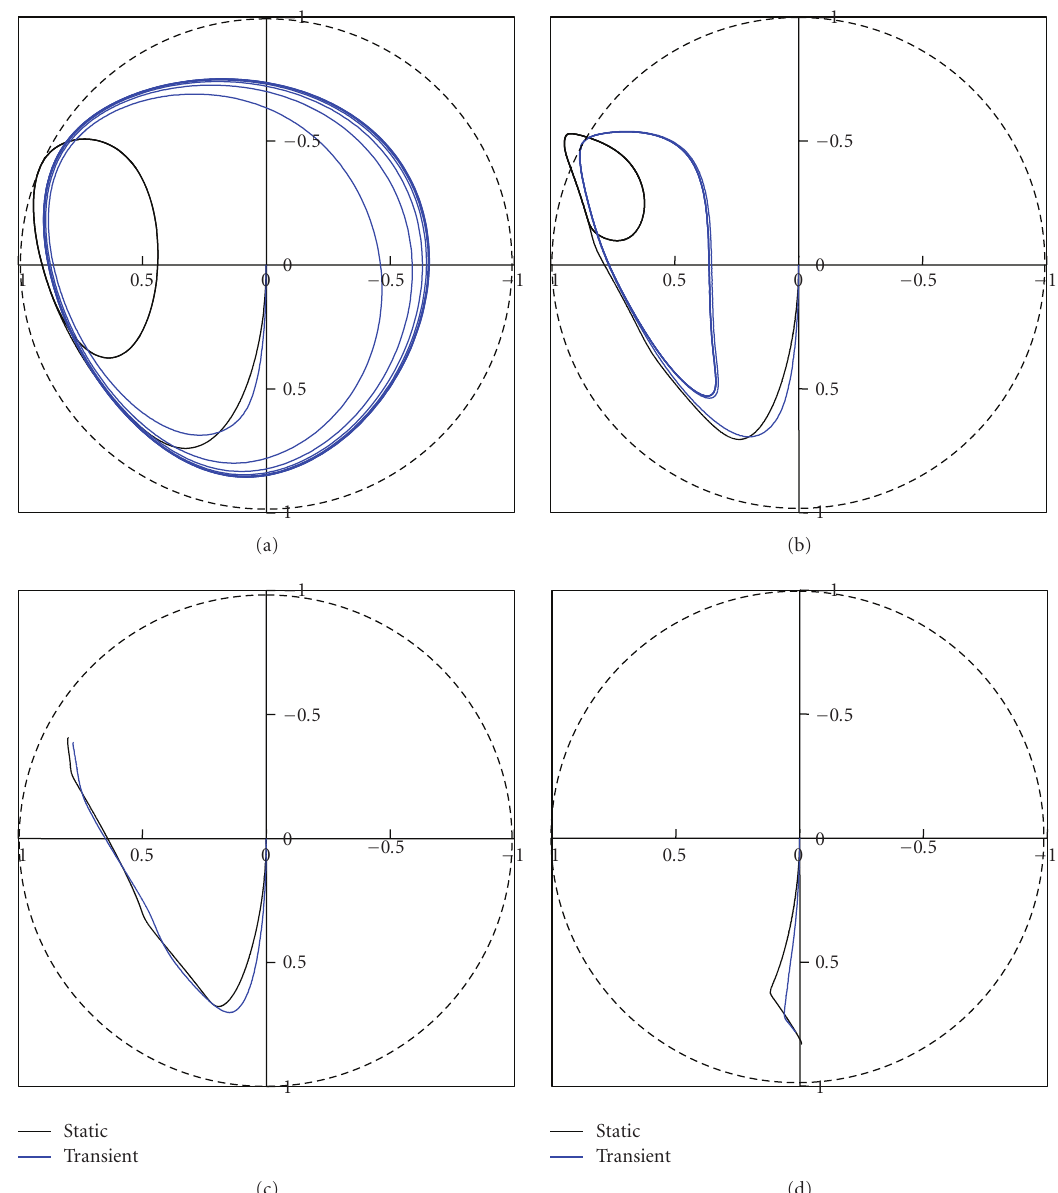
Figure 3: Trajectories path of rotor center (expressed as a ration of rotor centre position over bearing clearance), comparison between transient and static results for plain three-lobe bearings with load of 56.65g, Ω = 1000rpm, c = 40 μ m, l 0 = 25mm, and r 0 = 15mm and lobe eccentricities ( ε W 0 ) of (a) 0.0875, (b) 0.25, and (c) 0.375, (d)